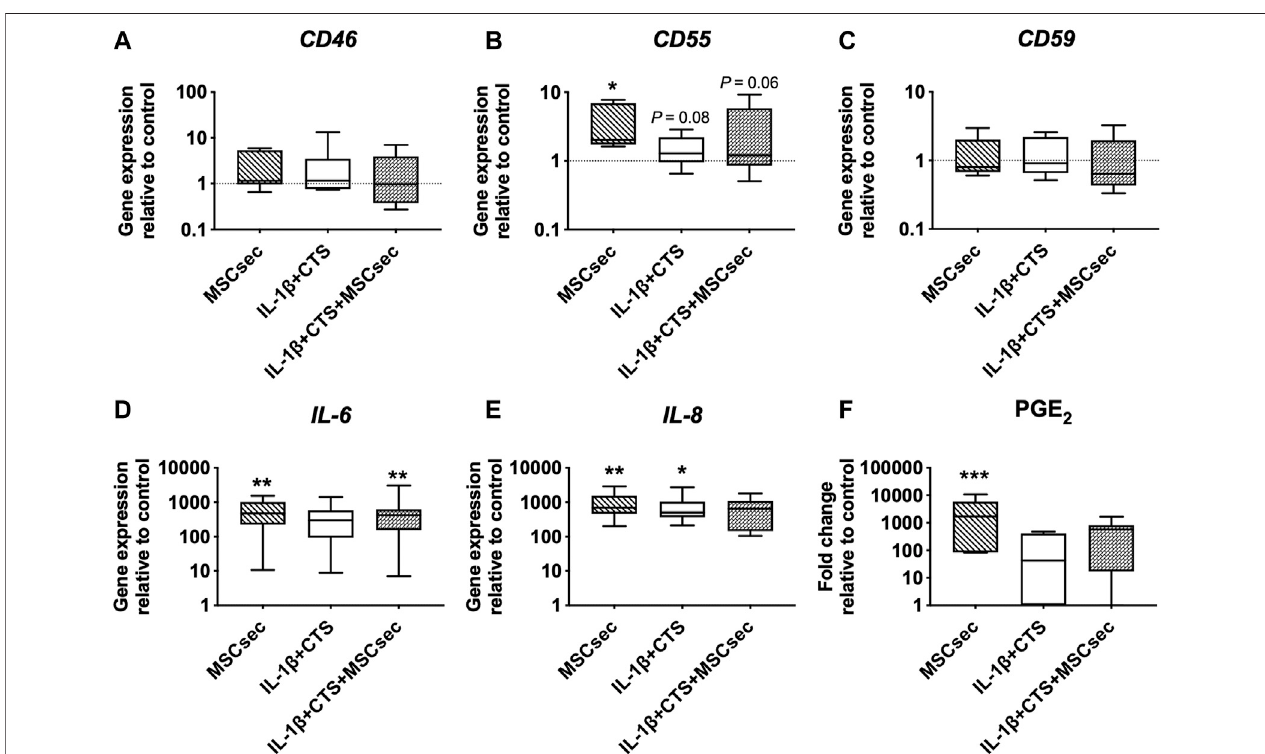
FIGURE 4 | Effect of MSC secretome on human AF cells stimulated with cyclic tensile strain (CTS) and IL-1 β (10 ng/ml) in the expression of complement markers and pro-in fl ammatory cytokines after 48 h. Relative mRNA expression of complement regulatory factors (A) CD46 , (B) CD55 , and (C) CD59 ; and pro-in fl ammatory markers (D) IL-6 and (E) IL-8 .Resultswerenormalizedtoexpressionlevelof GAPDH andtounstimulatedcells. (F) Concentrationofpro-in fl ammatorymarkerPGE 2 (fold change to unstimulated cells). n (cid:1) 7, * p < 0.05, ** p <